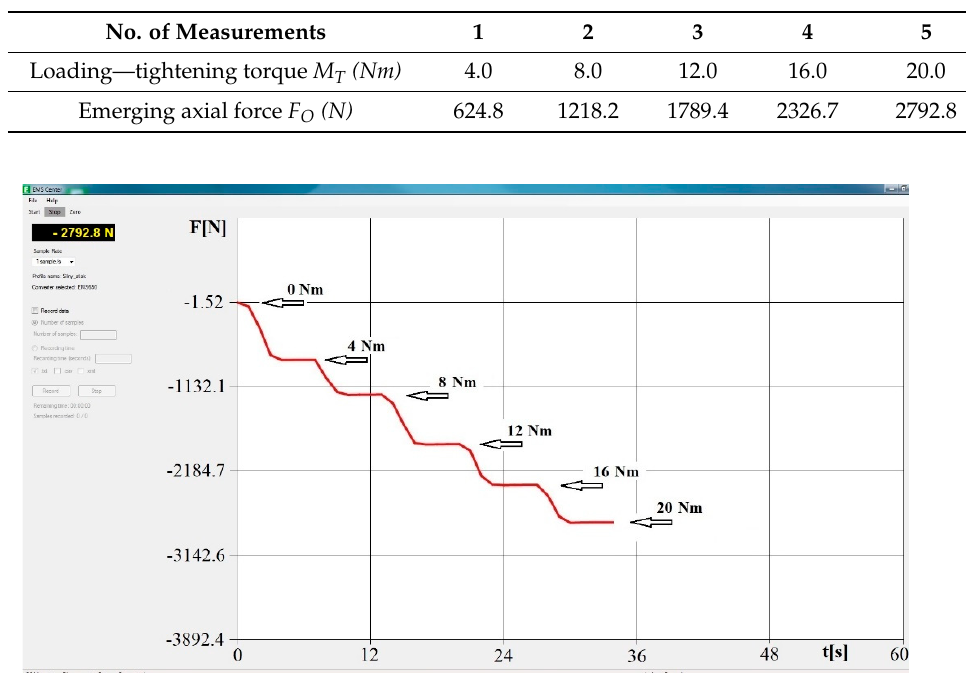
Figure 8. Dependence of the emerging axial force F O on time from the EMS Center software.